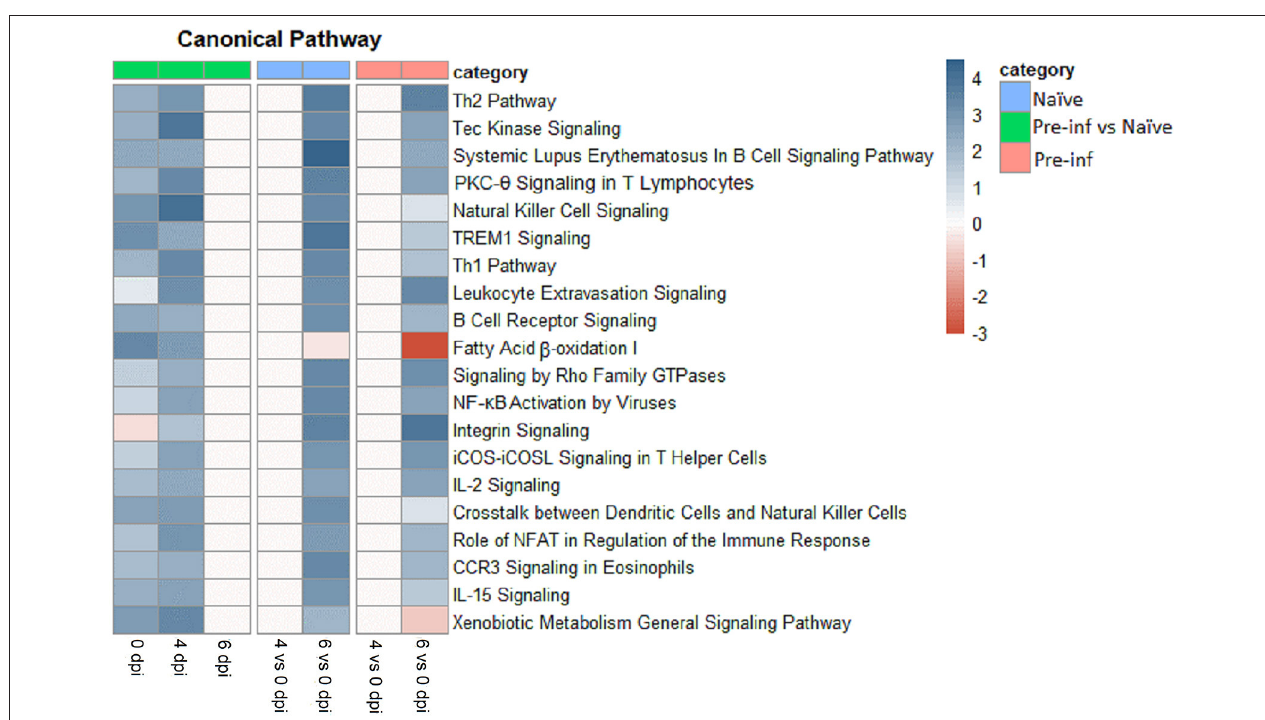
FIGURE 2 | Top 20 canonical pathways of differently expressed genes for naïve and pre–infected (pre–inf) kids comparing 0 vs. 4 and 6 days post–infection and pre–infected vs. naïve at 0, 4, and 6 dpi.